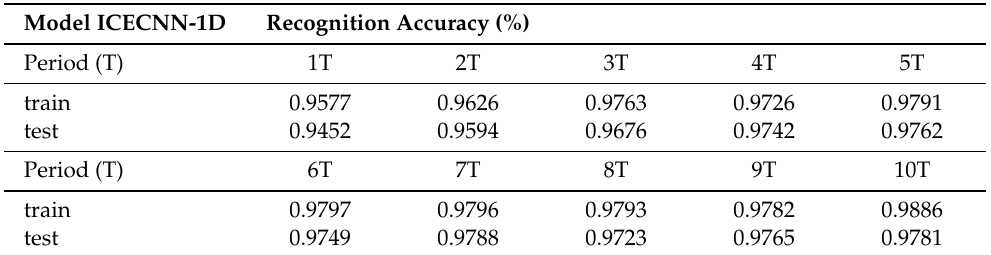
Table 4. Experimental results under different timing widths of ICECNN-1D model.